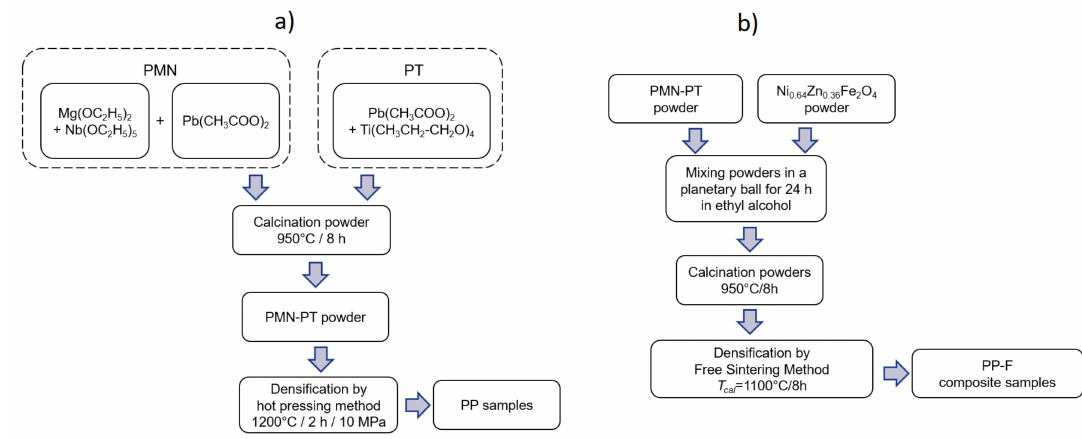
Figure 1. General scheme of technological process: ( a ) of the (1 − x )PMN- x PT (PP) materials, ( b ) PMN-PT-ferrite (PP-F) composite